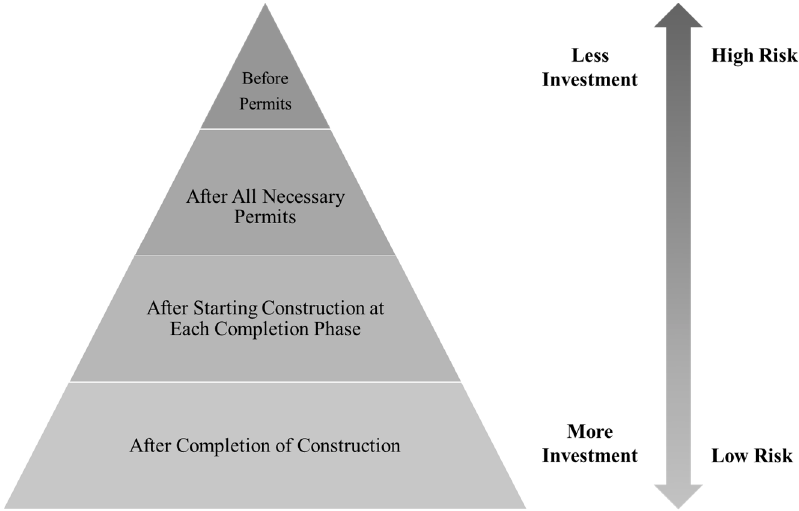
Figure 4. The Main Stages of the Off-Plan Sales Program Compared with Risk Levels.